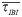
Measurement of τIBI¯ as a function of concentration of DHK for cultures at 33 to 34 DIVs (N = 3).The error bars are one standard deviation from 3 samples. The inset shows a comparison to simulation results from the TMX model described in the text. Note that τx controls the recycling time of neurotransmitters; playing similar role of DHK. Parameters for the TMX model are X0 = 0.95, J = 5.8, U = 0.3, I0 = −1.3, β = 0.01, τ = 0.013 s, τD = 0.15 s, τF = 1.5 s and α = 1.5.